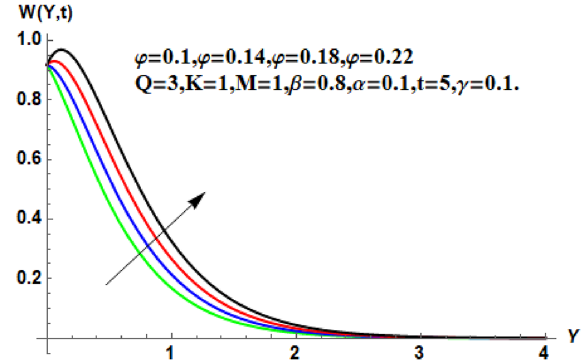
Figure 8. Velocity profile for different values of ¨ ϕ .